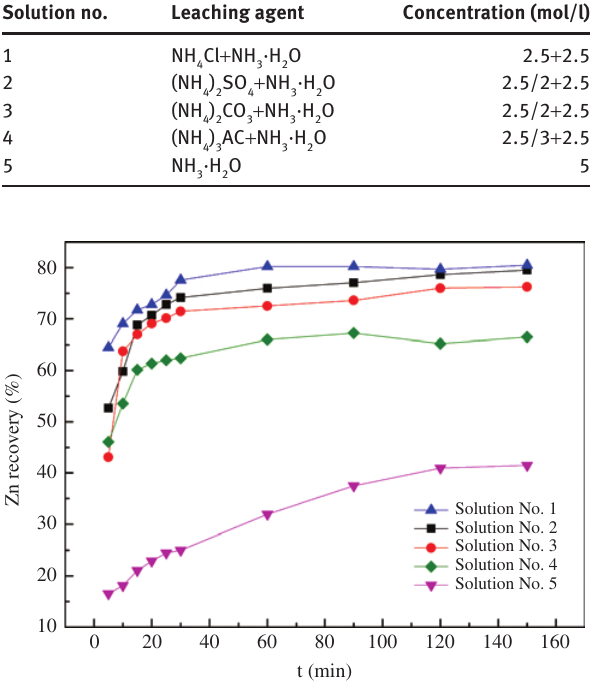
Figure 4: Zinc extraction of blast furnace dust using different leach- ing agents as shown in Table 2 for different durations.